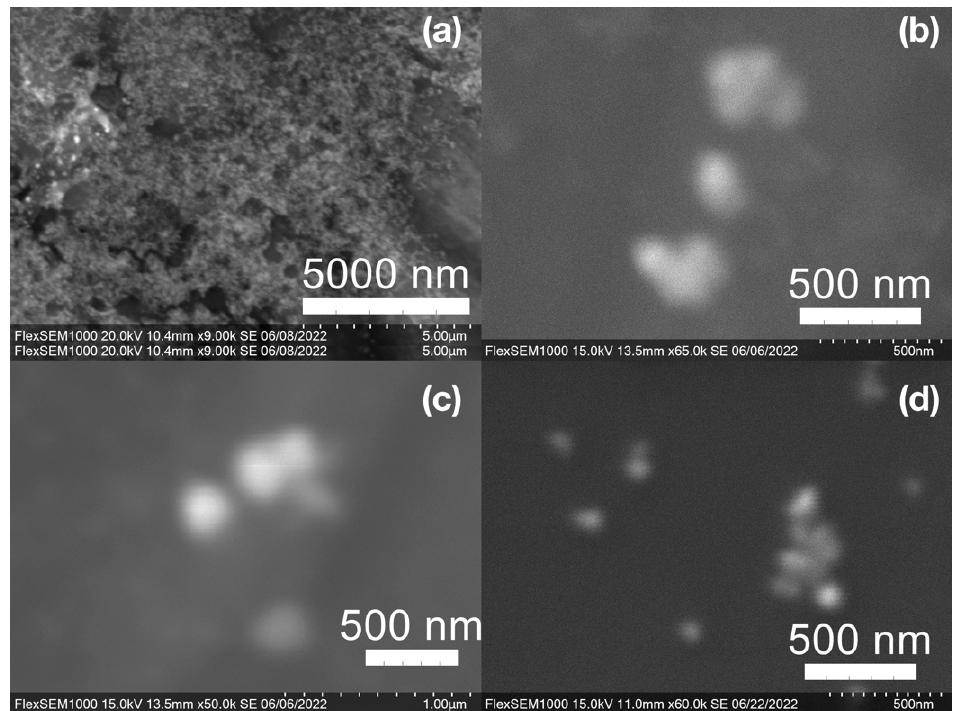
Figure 8. Gold (Au) nanoparticles synthesized with ( a ) medium roast coffee grounds (SCGs) from French press brew (SMH); ( b,c ) dark roast SCGs from espresso brew (SDE); and ( d ) medium roast SCGs from cold brew (SMC).